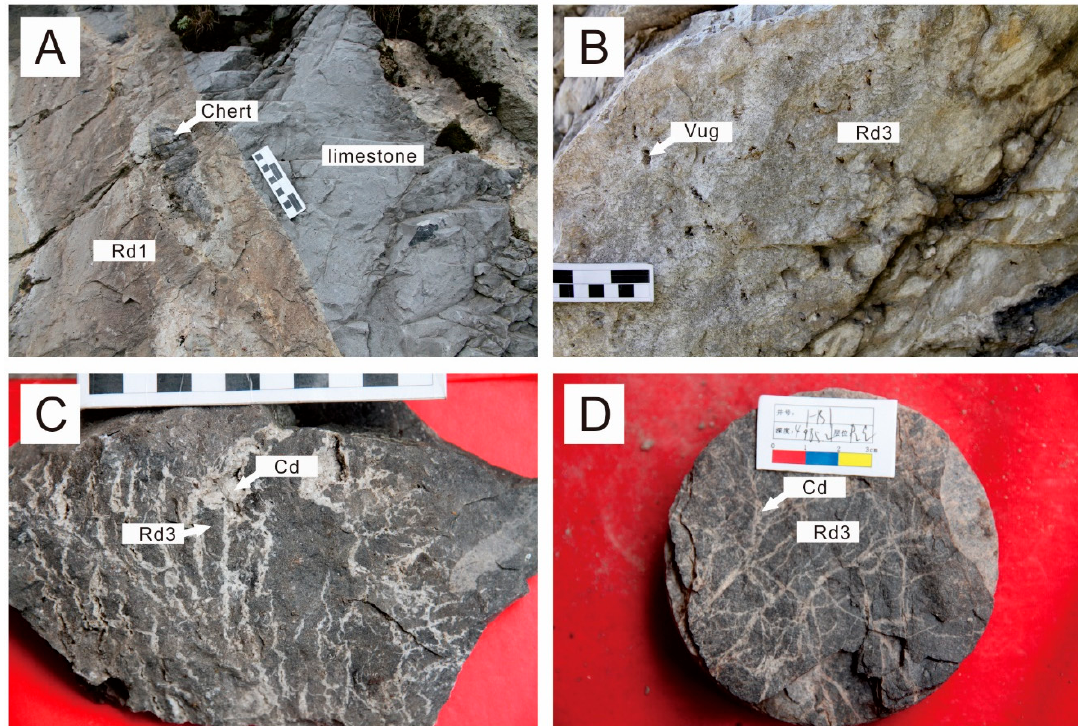
Figure 3. Field and core photos. ( A ) Field photo (Xinjigu; P 2 m ) showing micritic dolomite (Rd1) has the characteristics of stratified development with chert; ( B ) field photo (Xinjigu; P 2 q ) showing dissolved vugs developed in replacive dolomite; ( C ) field photo (Zhangcun; P 2 q ) showing zebra fabrics developed in dolomitized host rock (medium-to-coarse dolomite, Rd3), fractures are filled by white dolomite cement (Cd); ( D ) core photo showing dissolved vugs and network fractures developed in dolomite which are filled by white dolomite cements (Cd) (4985.2 m, Well Hanshen1; P 2 q ).